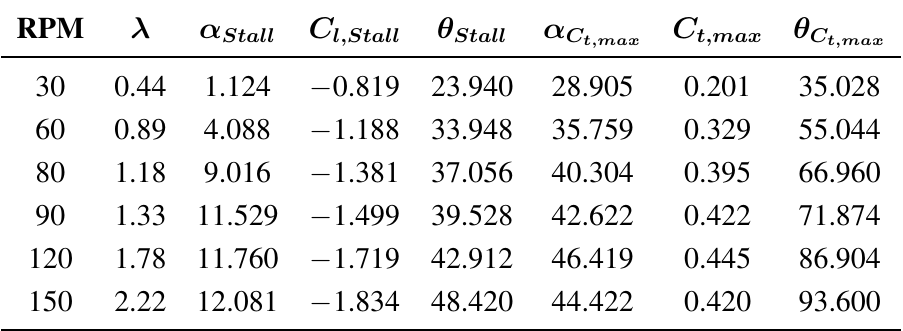
Table 2. Stall and maximum torque data at different λ